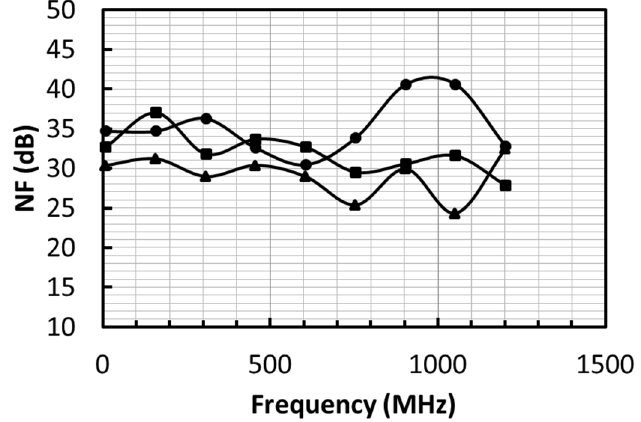
Figure 21. Noise figure measurement results of the TX analog baseband from three chip samples. Table 2. Performance Summary and Comparison.